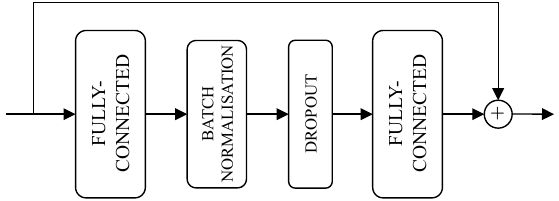
Figure 3. ResNet: Neural Network with skip connec- tions